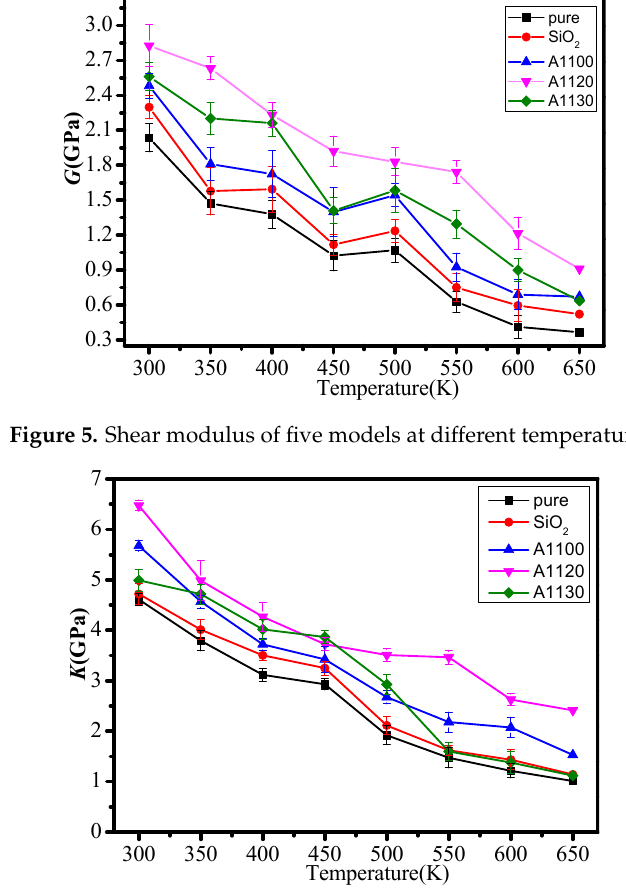
Figure 6. Volume modulus of five models at different temperatures.